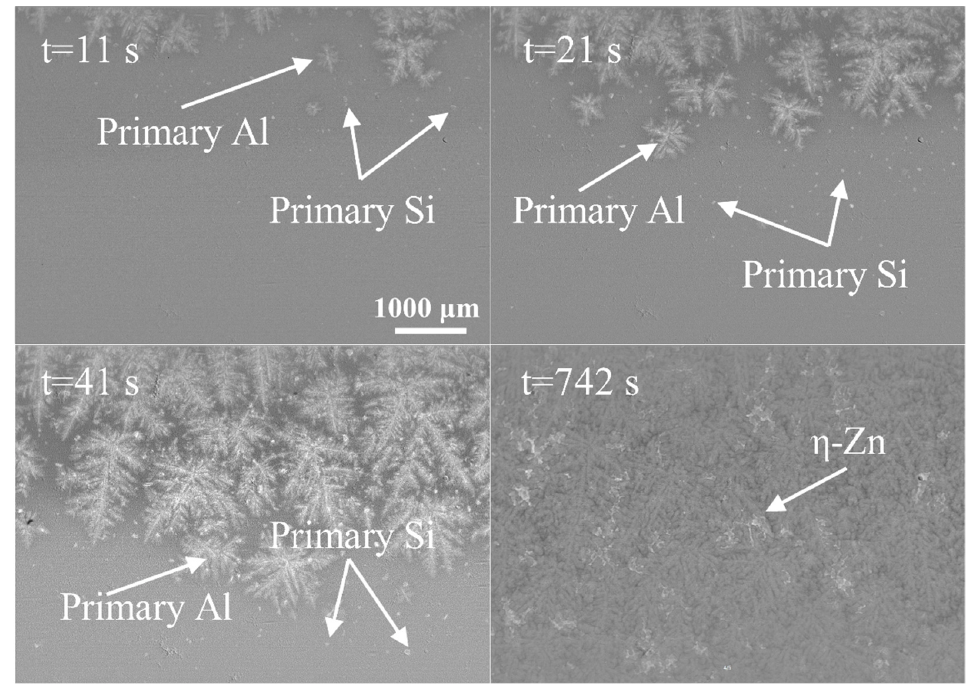
Figure 7. Synchrotron radiation images of Al-40Zn-5Si alloy during solidification at different times.